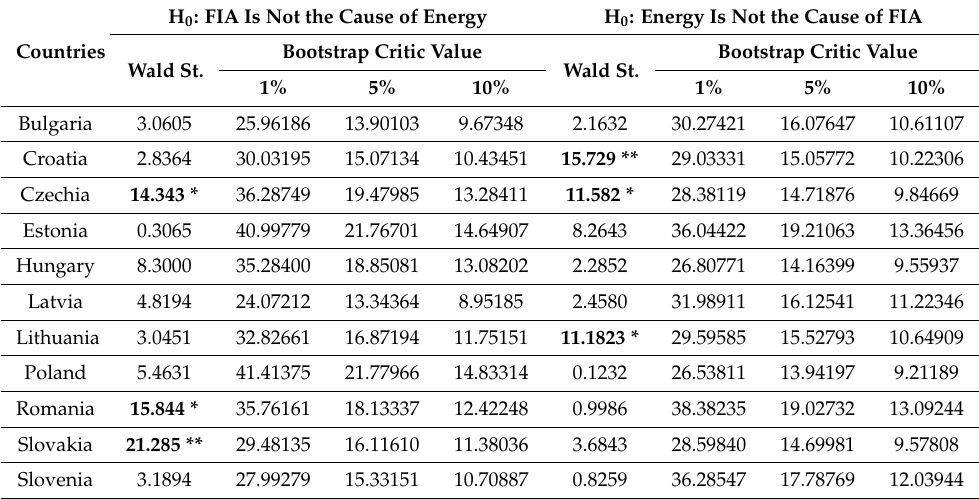
Table 10. Causality analysis between financial institutions accesses and primary energy consumption.